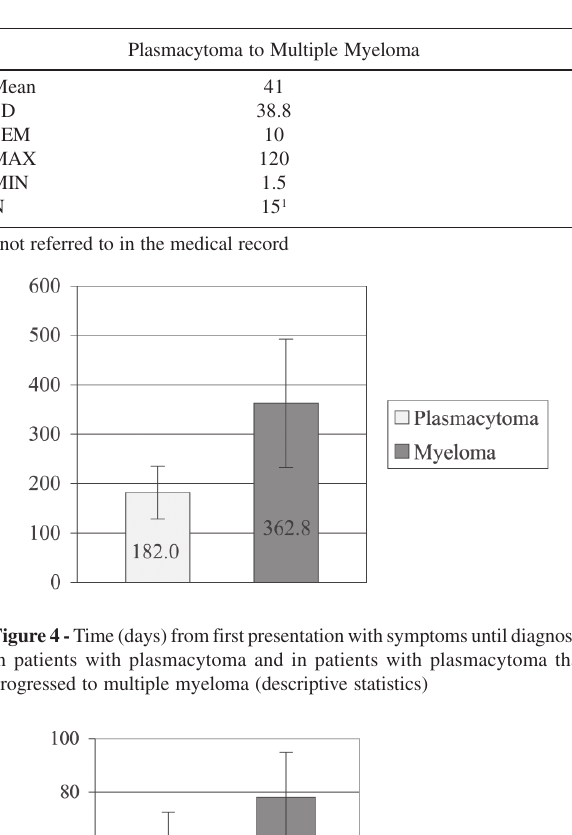
Table 6 - Progression time (months) in patients with plasmacytoma that progressed to multiple myeloma (descriptive